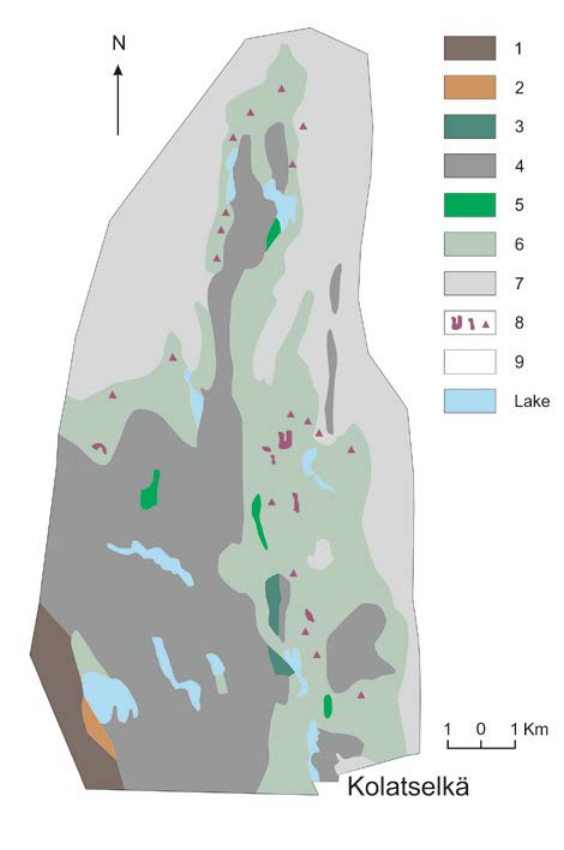
Figure 4. The bedrock in the area north of Kolatselkä village. 1: granite and rapakivi; Figure 5. Flooded rich fen east of Vieljärvi in 2007. Researchers, from left to right: Hanna Kondelin, (photo: Raimo